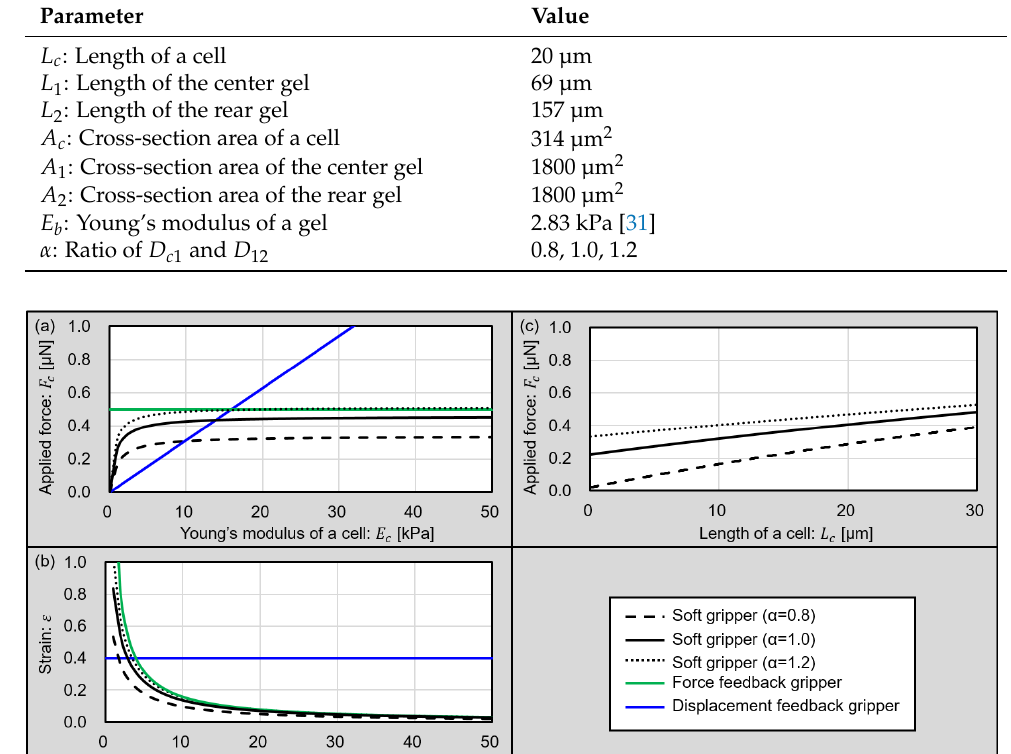
Table 1. Parameters for theoretical analysis.